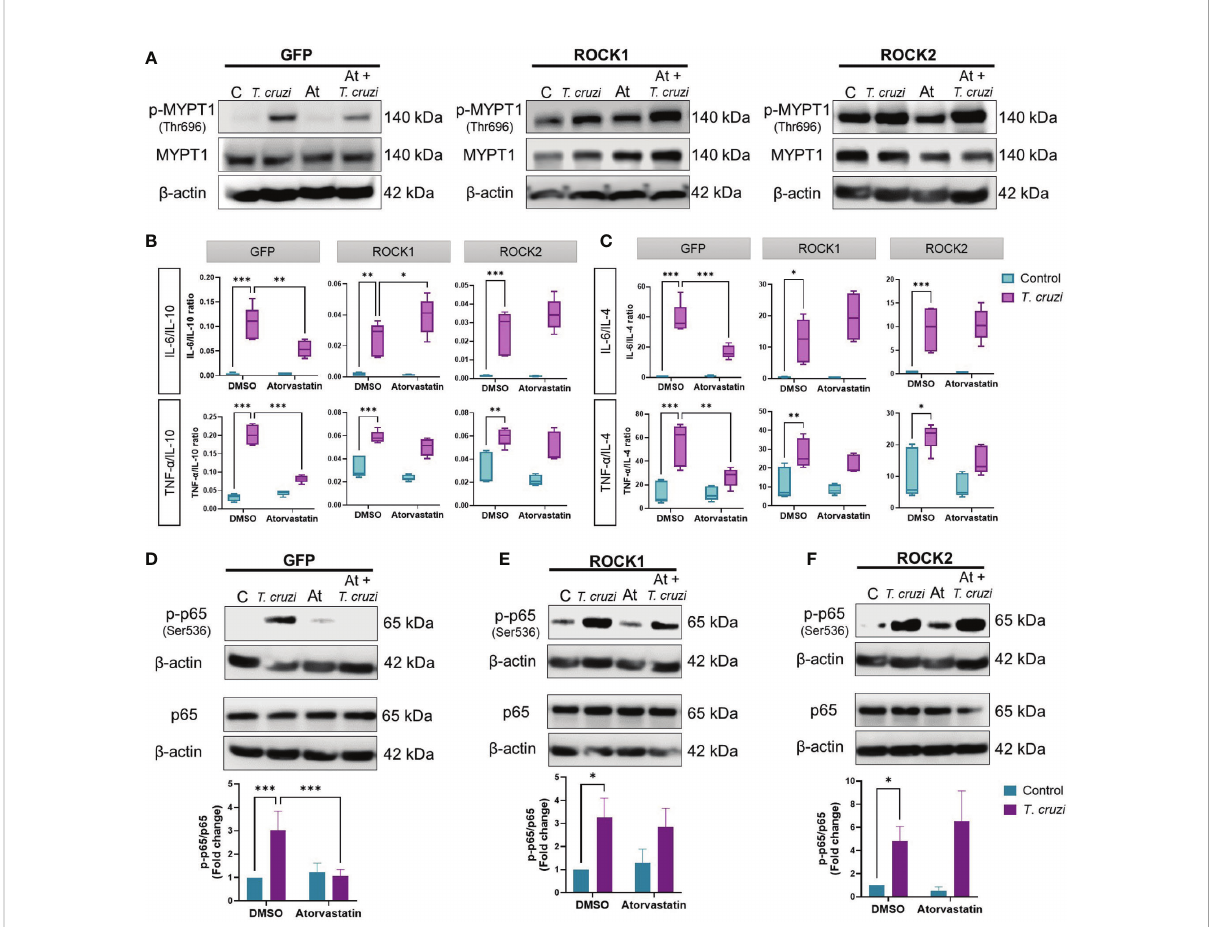
FIGURE 4 ROCK inhibition is necessary for the anti-in fl ammatory effect of atorvastatin in T. cruzi -infected macrophages. PMA-induced, GFP-, CA-ROCK1- and CA-ROCK2-expressing U937 cells were incubated with atorvastatin or DMSO (vehicle) for 24 h and then incubated with or without T. cruzi for 30 min. (A) ROCK activation was determined by western blot. (B, C) 24 h post- T. cruzi incubation, cell media were collected for Multiplex analysis of cytokine secretion, and M1/M2 ratios were determined. (D – F) NF- k B activation was determined by western blot as the ratio of phosphorylated (p-p65(Ser536)) to total p65. Data are expressed as mean ± SD of 5 (B, C) or 3 (A, D – F) independent experiments. *p<0.05, **p<0.01, ***p<0.001, analyzed with two-way ANOVA and Tukey